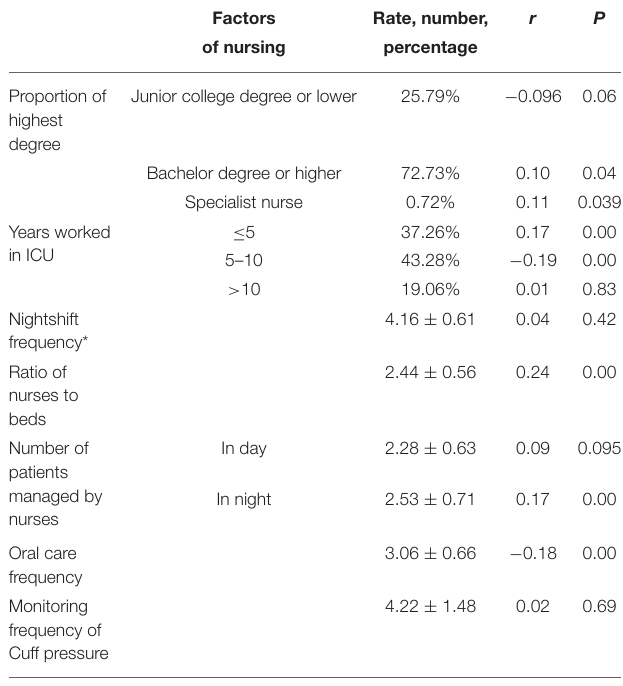
TABLE 3 | Correlation between ventilator-associated pneumonia (VAP) and related nursing factors.